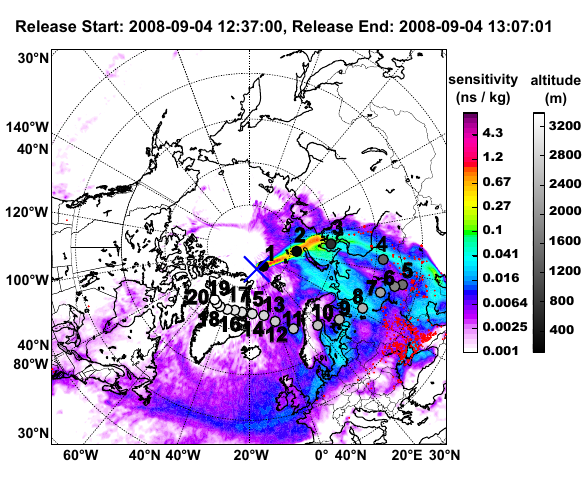
Fig. 12. FLEXPART modelled footprint potential emission sensitiv- ity for 4 September 2008, 12:37 (DOY 248.5). The Oden ’s position is marked by the blue cross and the red dots represent fires detected by MODIS.